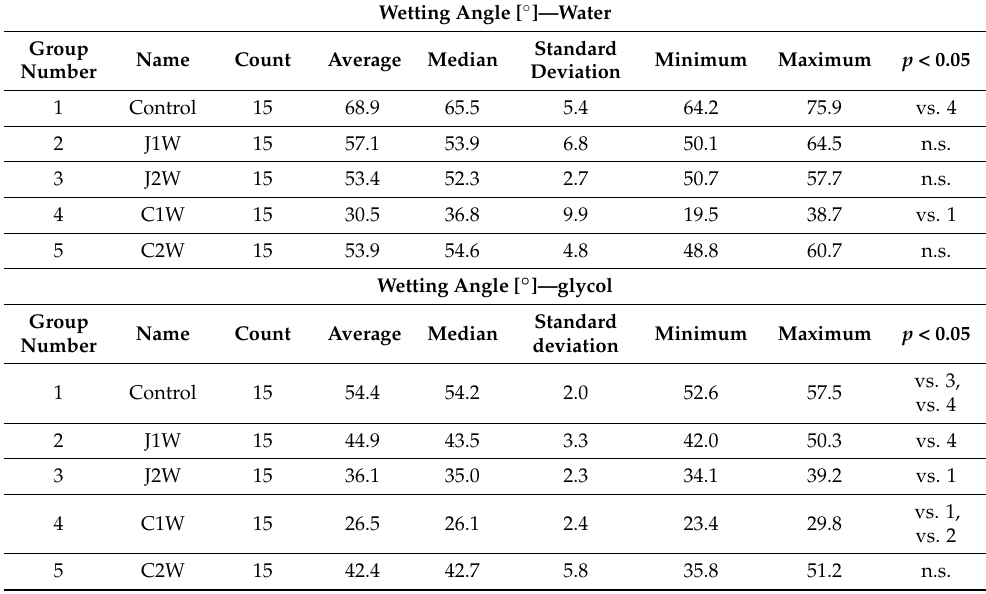
Table 5. Summary statistics of water and glycol wetting angle, and results of Kruskal–Wallis